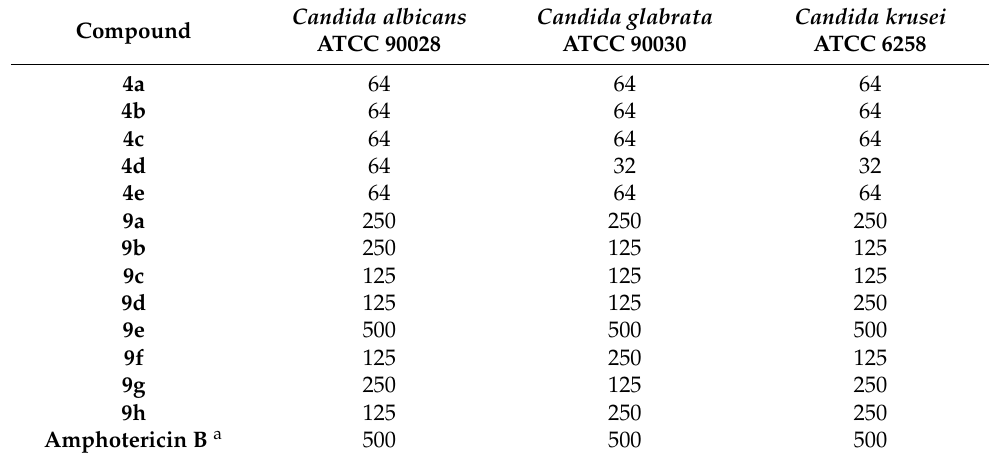
Table 5. Antifungal activity of synthesized compounds 4 and 9 (MIC was determined in µ g/mL).